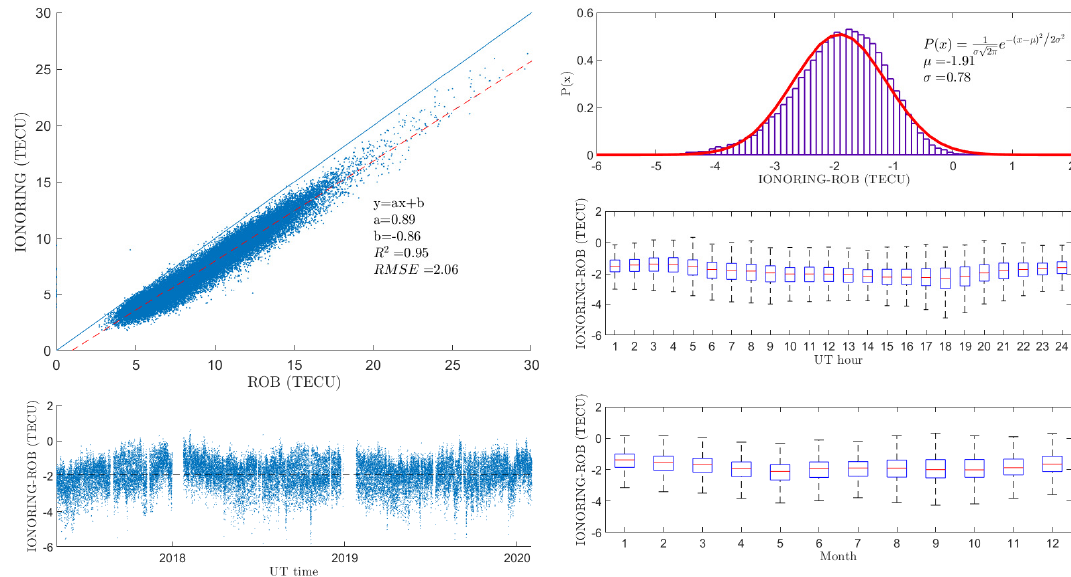
Figure 3. The same as Figure 2 but referring to the IONORING validation against the vTEC maps provided by the Royal Observatory of Belgium (ROB). The linear fit (red-dashed line) and its features (in the textbox) are reported, while the blue line indicates the bisector (panel a ). Time profile of the difference between IONORING and ROB vTEC (panel b ). Probability distribution of the difference between IONORING and ROB vTEC and the corresponding Gaussian fit (red), whose expression and parameters are also reported in the textbox (panel c ). Boxplots of the hourly (panel d ) and monthly (panel e ) differences between IONORING and ROB vTEC. In the boxplots, the red line indicates the median, and the bottom and top edges of the box indicate the 25th and 75th percentiles, respectively, while the range marked by the dashed lines indicates the extrema.